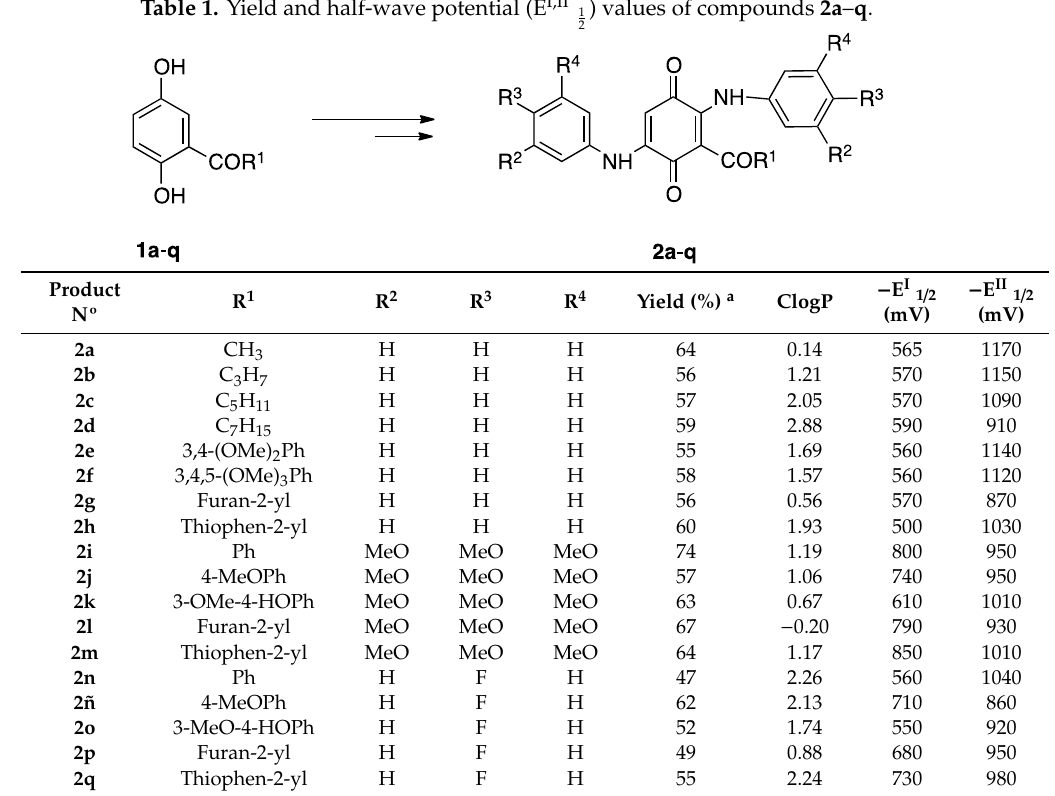
Table 1. Yield and half-wave potential (E I,II ½ ) values of compounds 2a – q